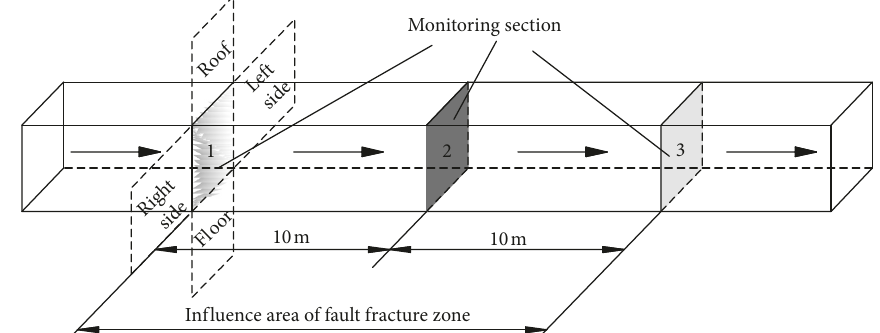
Figure 10: Layout of roadway monitoring section.